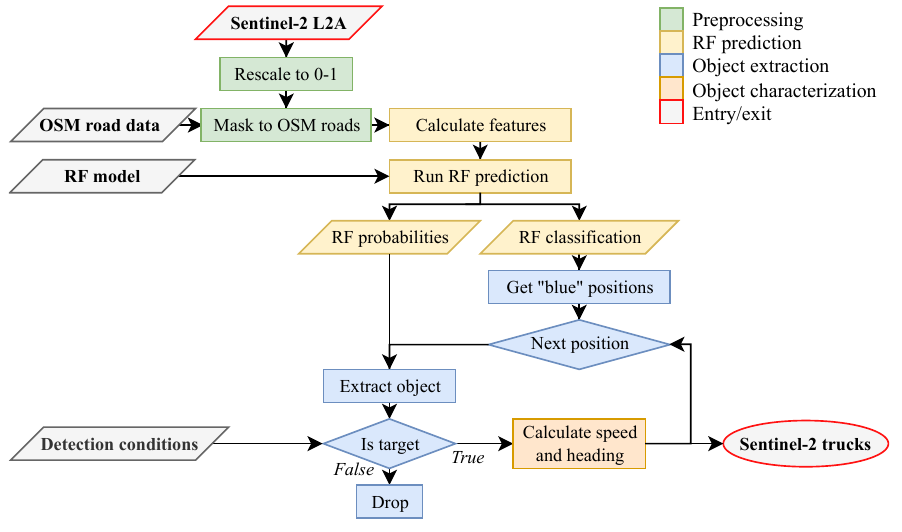
Figure 4. Object detection